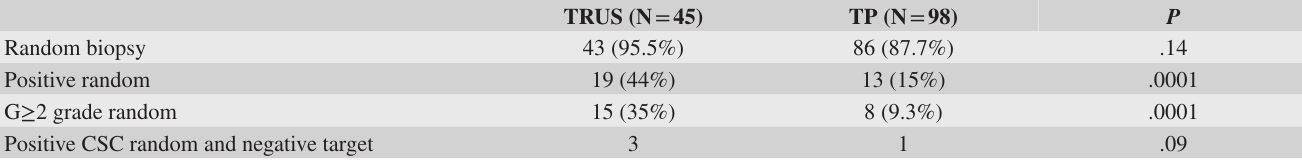
Table 3. Difference of Detection Rates of Cancer and Grade ≥ 2 Cancer on Random Cores Between Transrectal (TRUS) Versus Transperineal Biopsy of Prostate (TP)